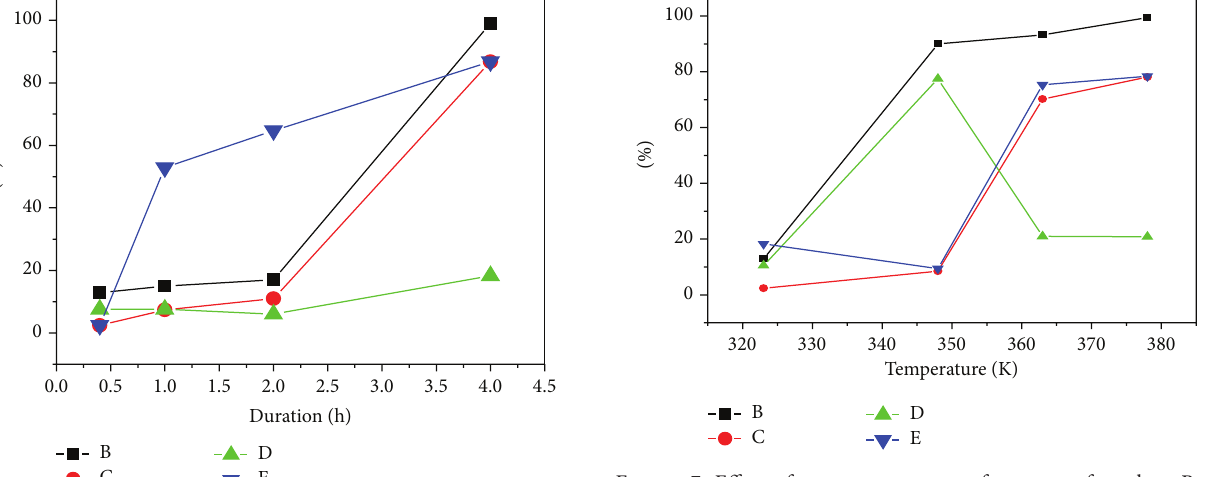
Figure 7: Effect of temperature on performance of catalyst. B = conversion, C = 2-PEA yield, D = others, and E = 2-PEA selectivity.